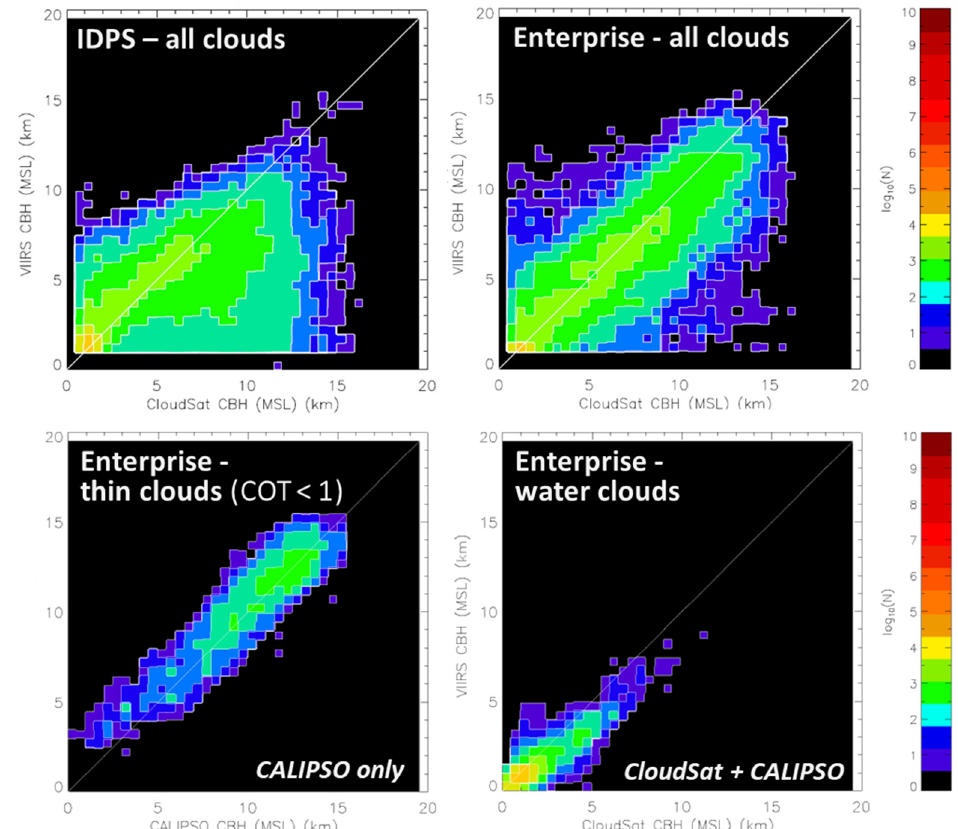
Figure 4. An example of comparisons with independent CloudSat radar and CALIPSO lidar data (modified from Noh et al. 2017). “Within-spec” two-dimensional histograms of VIIRS-retrieved and CloudSat-observed CBH for the original IDPS CBH algorithm with CLAVR-x input ( upper left ), and ( right ) the statistical Enterprise algorithm (implemented in the CLAVR-x system) for September–October 2013. The bottom panels show optically thin clouds from the Enterprise CBH algorithm compared with CALIPSO lidar data and water clouds compared with CloudSat and CALIPSO combined data, respectively. Colors represent the number of data points (N; shown on a logarithmic scale). The comparisons are valid for all cloud types encountered globally.